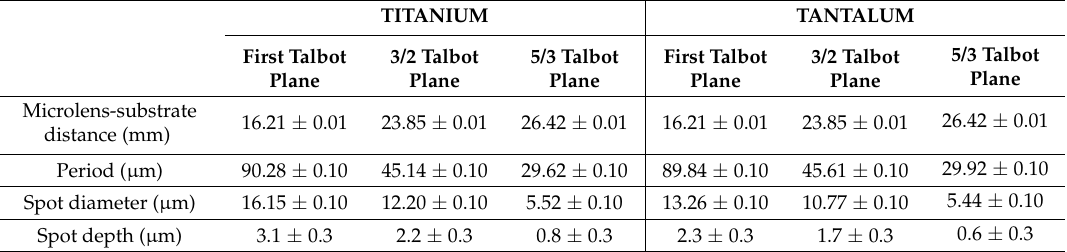
Table 1. Experimental parameters of the micro-patterns fabricated over titanium and tantalum.